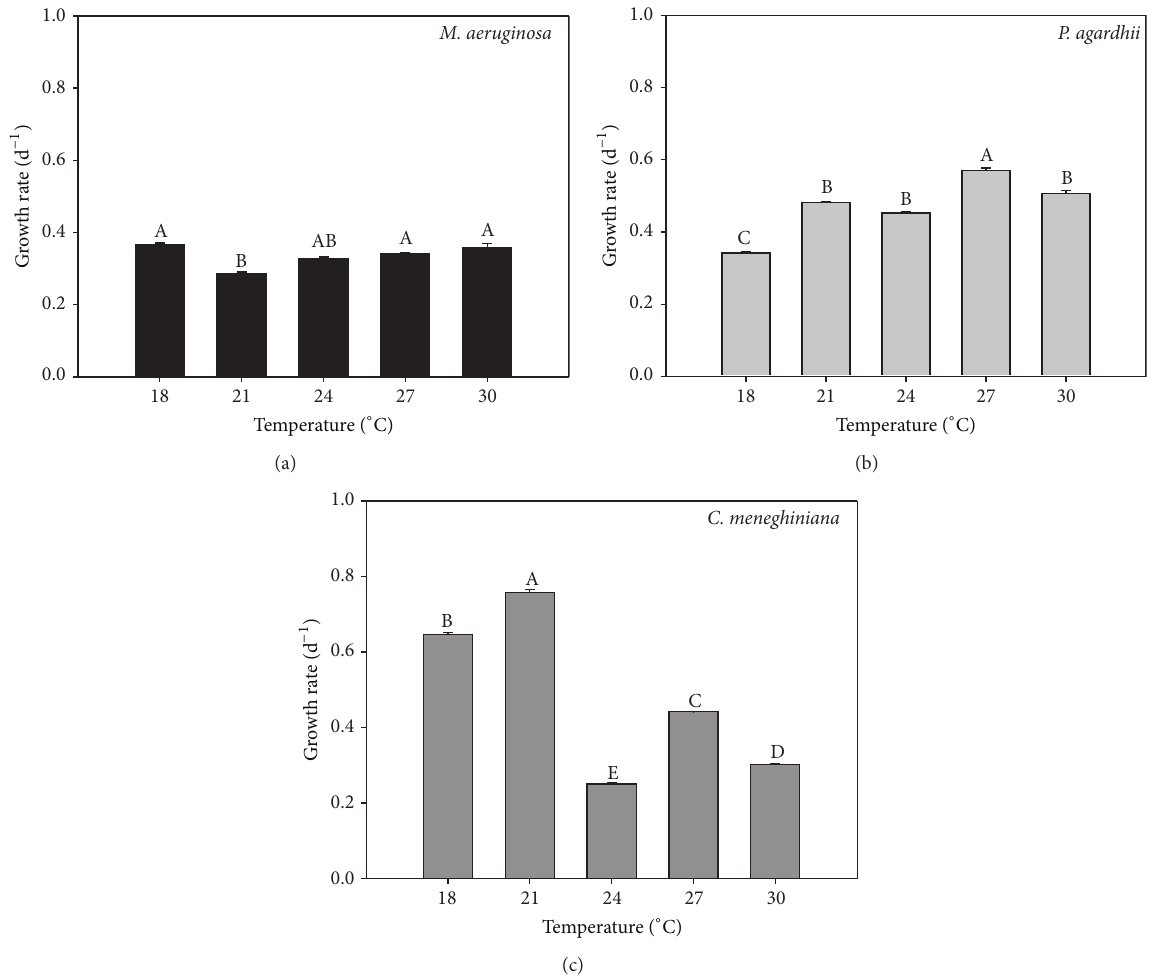
Figure 2: Chlorophyll-a-based growth rate of M. aeruginosa (a), P. agardhii (b), and C. meneghiniana (c) cultured at different temperatures. Different letters represent significant differences at 𝑝 < 0.05